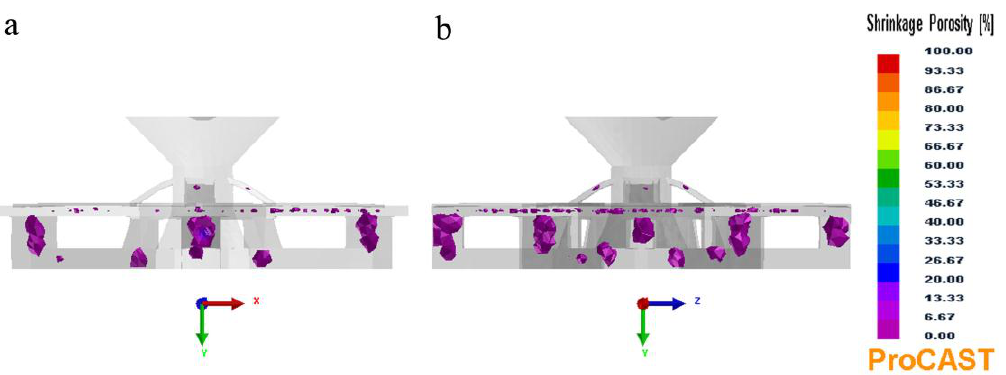
Figure 7. Slice view at a mold temperature of 800 °C and rotation speed of 400 rpm, ( a ) disk and ( b ) rib.